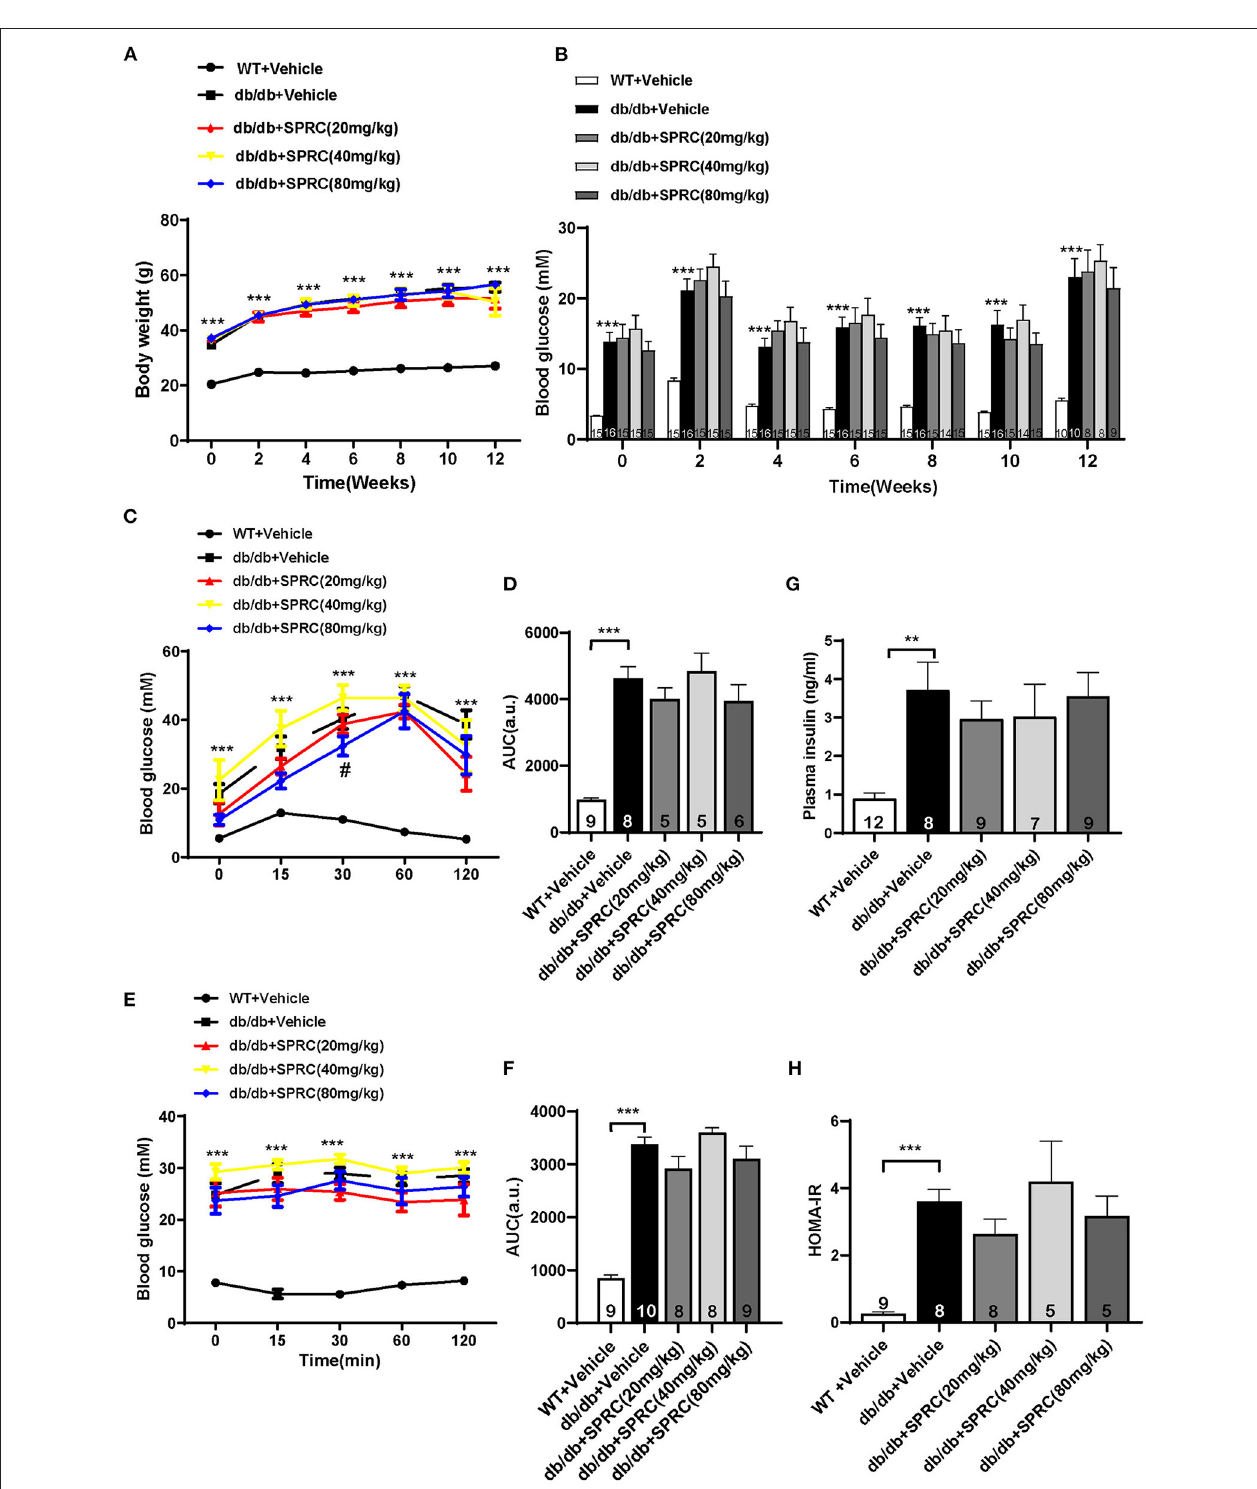
FIGURE 5 | SPRC treatment improves glucose tolerance in db/db mice, with fasting blood glucose and systemic insulin resistance remaining unchanged. Vehicle or SPRC (20, 40, or 80 mg/kg/day) was orally administered to WT mice or db/db mice for 12 weeks. (A) Body weight ( n = 8–16), (B) fasting blood glucose ( n = 8–16), (C) intraperitoneal glucose tolerance test (IPGTT) and (D) area under curve (AUC) of IPGTT ( n = 5–9), (E) intraperitoneal insulin tolerance test (IPITT) and (F) area under curve (AUC) of IPITT ( n = 8–10), (G) fasting plasma insulin ( n = 7–12), and (H) HOMA-IR index were determined ( n = 5–9). Values are presented as means ± SEM. ** P < 0.01, and *** P < 0.001 vs. WT + Vehicle group, # P < 0.05 vs. db/db + Vehicle mice.